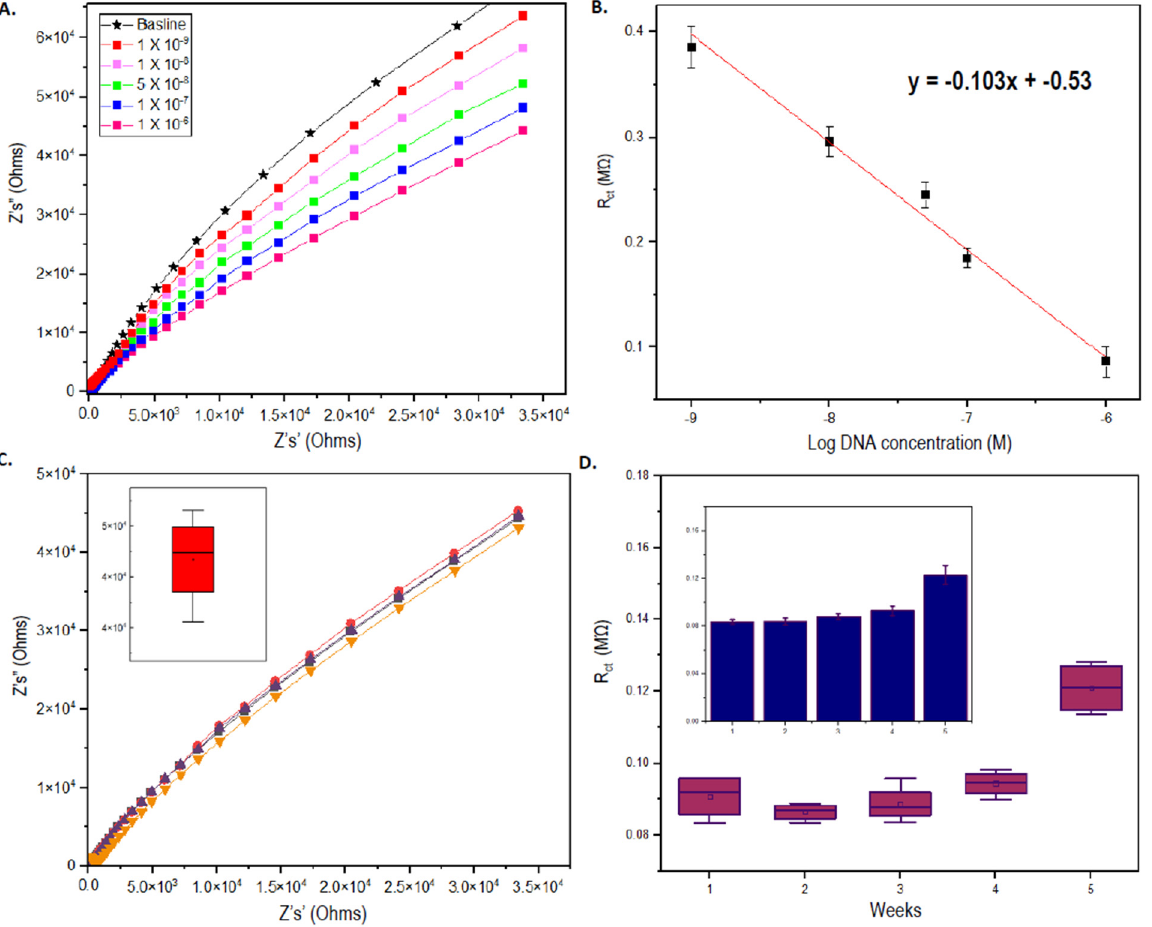
Figure 7. ( A ) Depicts the EIS signals obtained at each different target concentrations of FLT3 gene sequence. ( B ) Shows the plot of R ct values against Log DNA concentrations. ( B ) (inset) shows the R ct values at different surface probe concentrations ( C ) Shows the reproducibility of the sensor platform taken from four different sensor replicates. ( D ) Shows the stability of modified IDE sensors tested over 5 weeks.